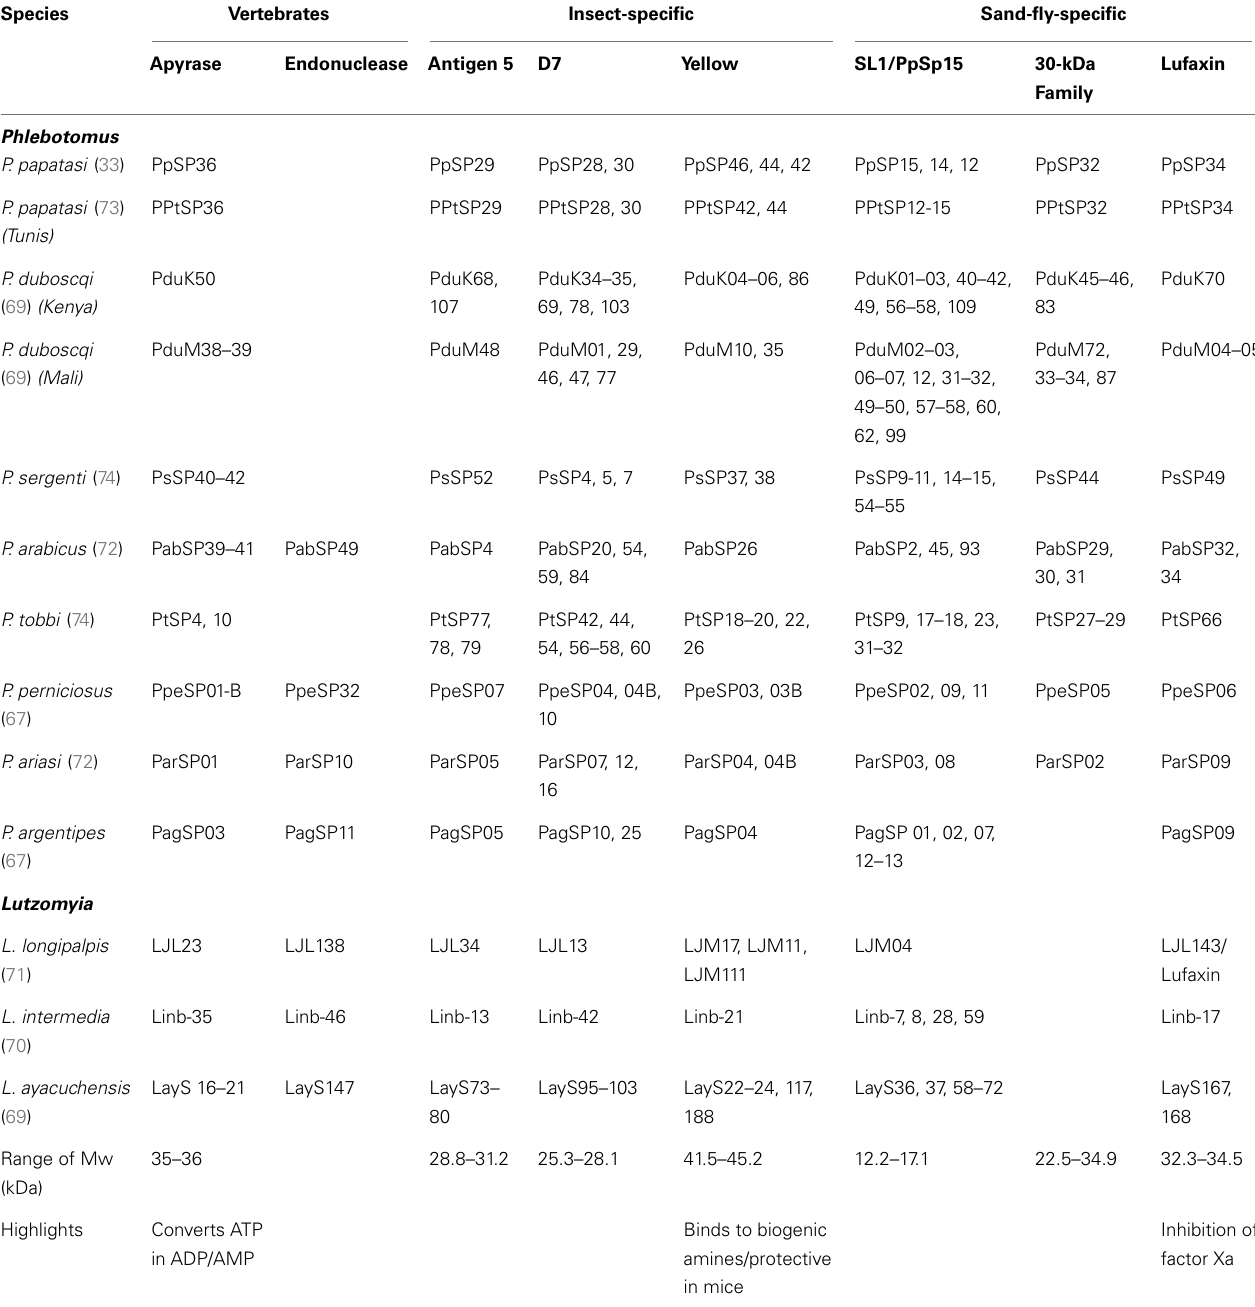
Table 2 | Families of most abundant Phlebotomus and Lutzomyia sand fly proteins